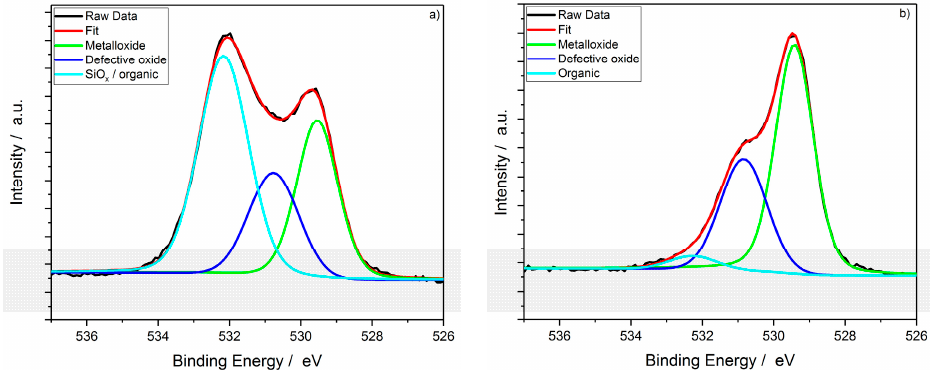
Figure 4. O 1 s detail spectra of deposit layer ( a ) and powder reference ( b ).